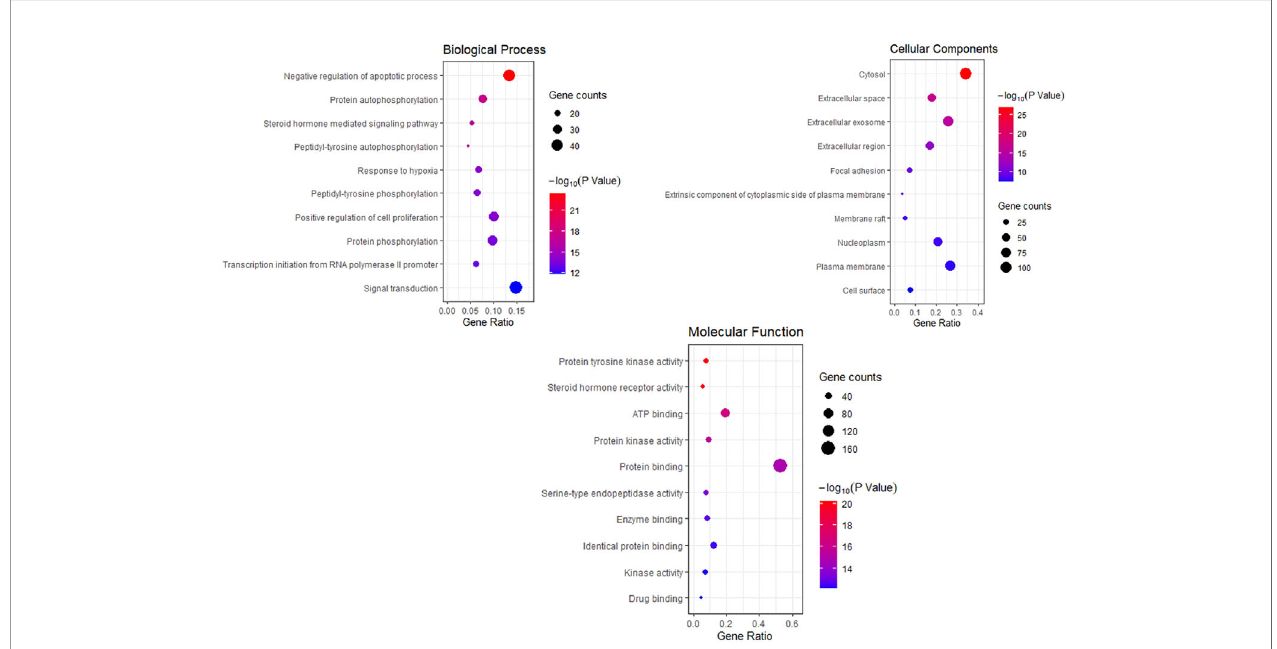
FIGURE 5 | Bubble Diagram of GO function enrichment of potential targets from the THSWD for Treatment of breast cancer. The larger the number of enriched targets, the larger the dots; the larger the P value, the bluer the dot color.